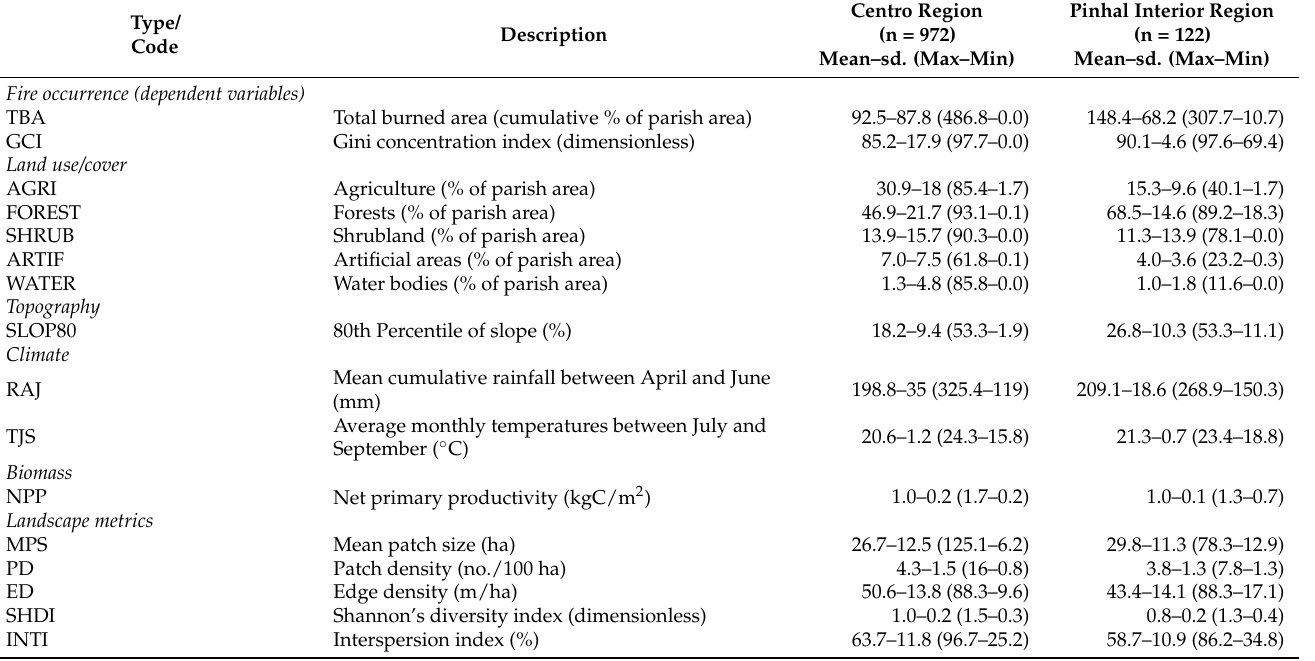
Table 1. Summary statistics for the variables used in fire regime model